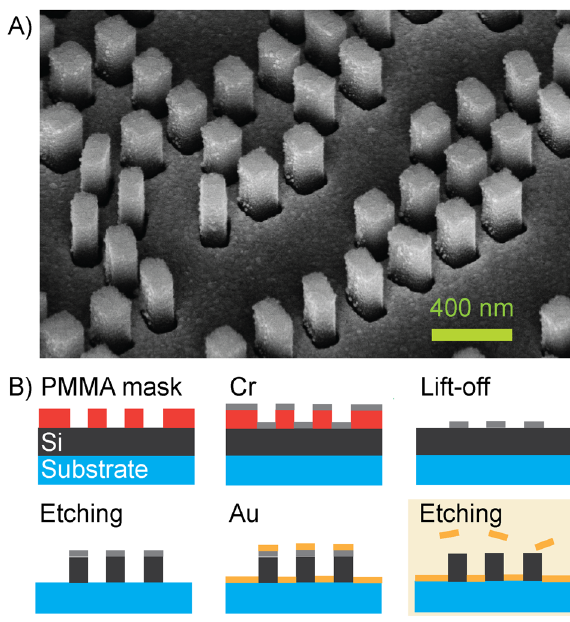
Figure 4: Scanning electron microscope image (SEM) of the fabricated sample and flow chart diagrams of the fabrication process.